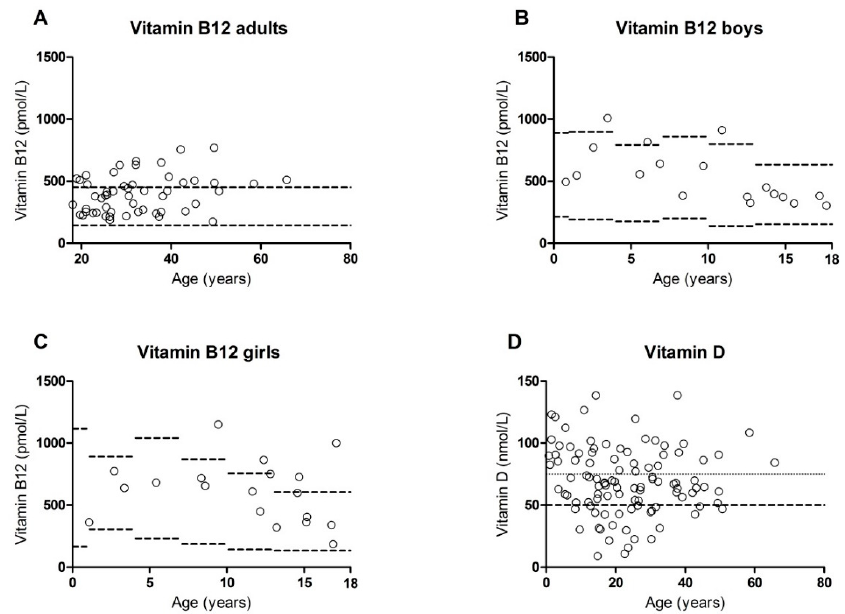
Figure 1. Distribution of vitamin concentrations in patients with reference ranges (depending on age). ( A ): Vitamin B12 concentrations in adult patients. ( B ): Vitamin B12 concentrations in male patients aged < 18 years. ( C ): Vitamin B12 concentrations in female patients aged < 18 years. ( D ): Vitamin D concentrations in patients with lower reference limit of 50 nmol / L and recommended limit of 75 nmol / L.